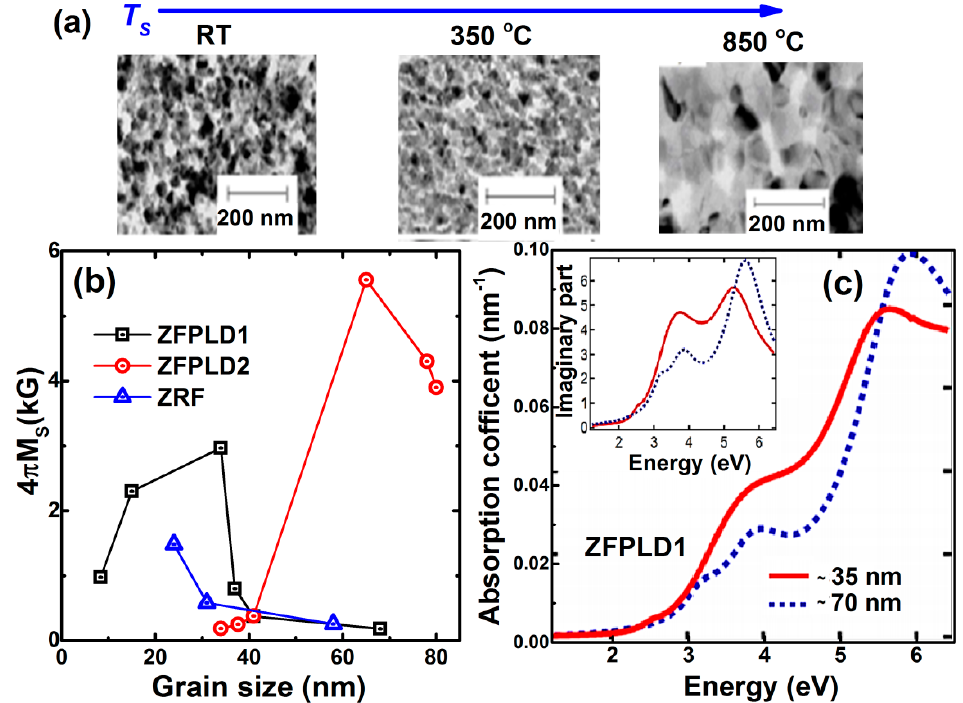
Figure 6. ( a ) TEM images of ZFPLD1 films grown at T S of RT, 350 °C and 850 °C exhibit their nanocrystalline nature ( b ) Room-temperature spontaneous magnetization (4 π Ms) values vs. grain sizes in ZFPLD1, ZFPLD2, and ZFRF films (Reproduced with permission from [39]. Copyright AIP Publishing, 2006). ( c ) Absorption coefficient of ZFPLD1 films with grain size of ~35 nm (full line) and ~70 nm (dashed line). Corresponding imaginary part of permittivity are plotted in the Inset (Reproduced with permission from [14]. Copyright AIP Publishing, 2015).